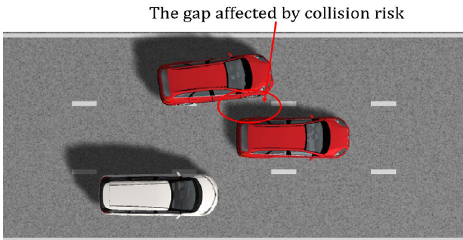
Figure 12. An example of collision risk preference.